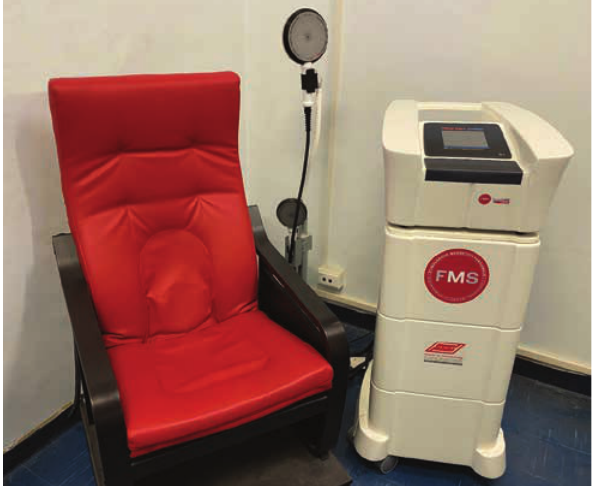
Figure 1: Tesla Care®Armchair for functional extracorporeal magne- tic stimulation